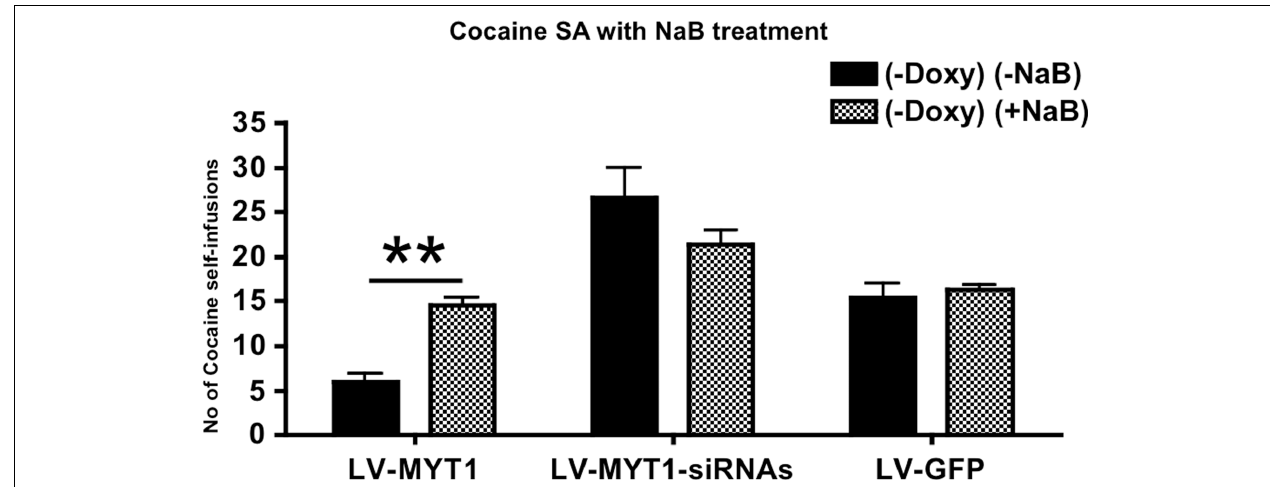
FIGURE 2 | The HDAC inhibitor Sodium Butyrate (NaB) reverses inhibition of self-administration mediated by NZF-2b/7ZFMyt1. At the end of Session C ( Figure 1 ), animals fed without doxycycline were administered NaB (100 mg/ kg, i.p.) 30 min prior to each cocaine self-administration tests, for three consecutive days. Values represent means ± SEM of self-infusions of cocaine in the three LV-treated groups ( n = 7). NaB treatment reverted the inhibition